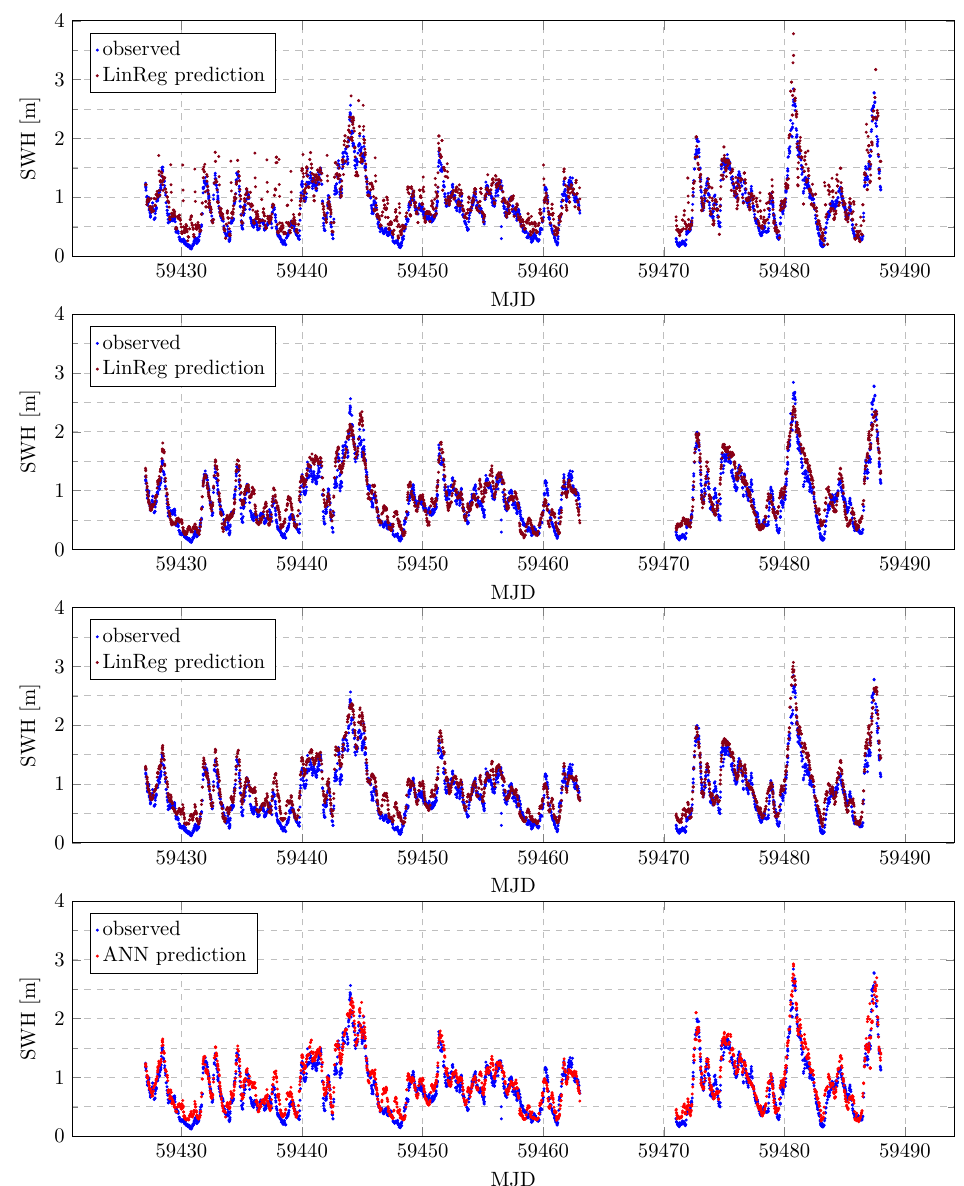
Figure 11. Time series of observed and estimated SWH for testing data available in August and September 2021 for selected estimates with the linear regression or the ANN. Predictor settings used, from top to bottom: 1 c , 29 a , 26 b , 31 b . For the intermittent part, the SWH radar sensor measurements were not available. We used the modified Julian date (MJD) as time reference on the horizontal